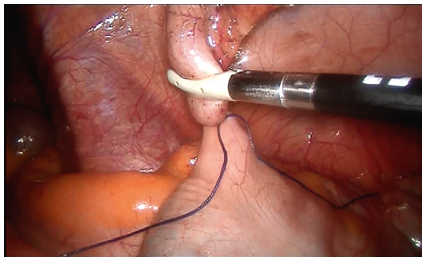
Figure 4: Removal of the